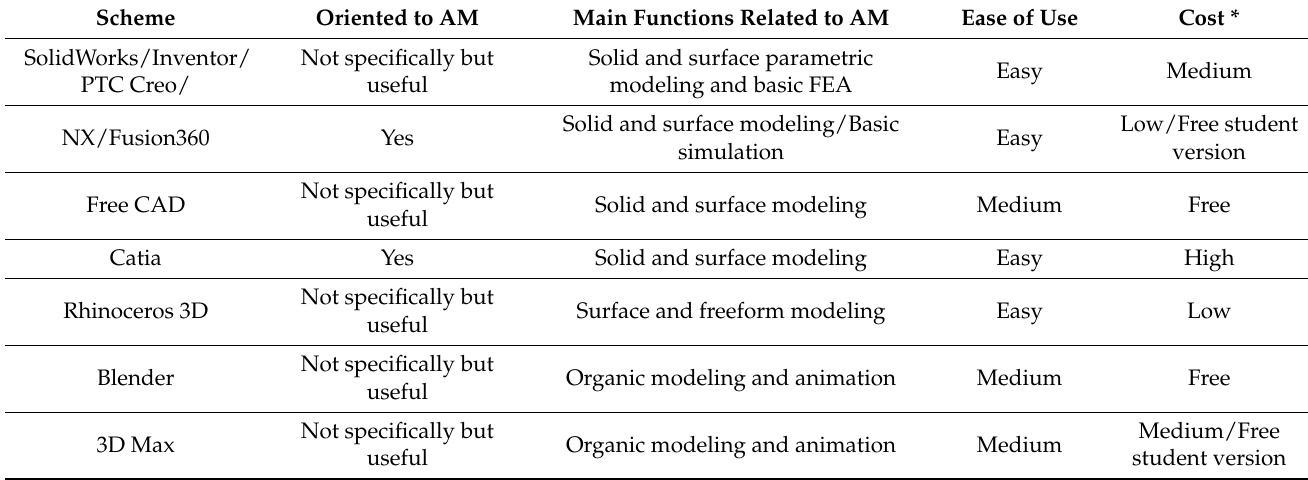
Table 1. List of remarkable software used in additive manufacturing design